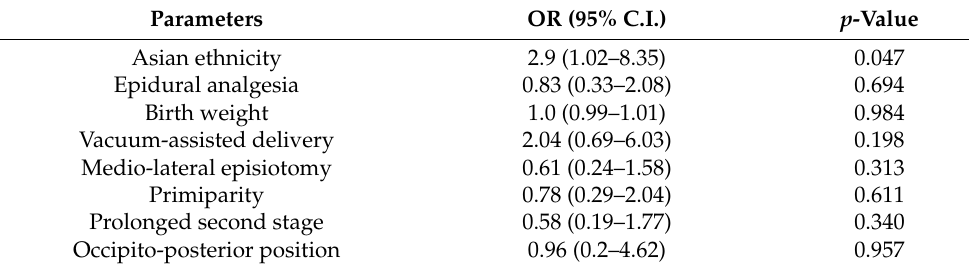
Table 3. A multivariable logistic regression analysis of risk factors for fourth-degree OASI.